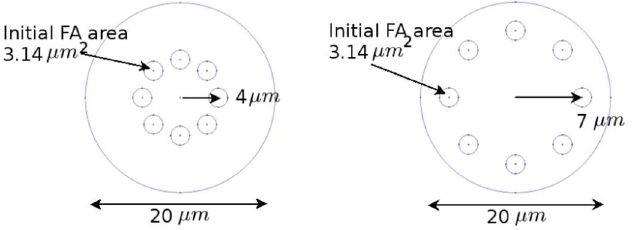
Fig 5. Initial FA configurations. Initial FAs are placedat a radial distanceof R = 4 μ m (left) or R = 7 μ m (right). From this initial configuration FA location evolves in a stress dependent manner as describedby Eq